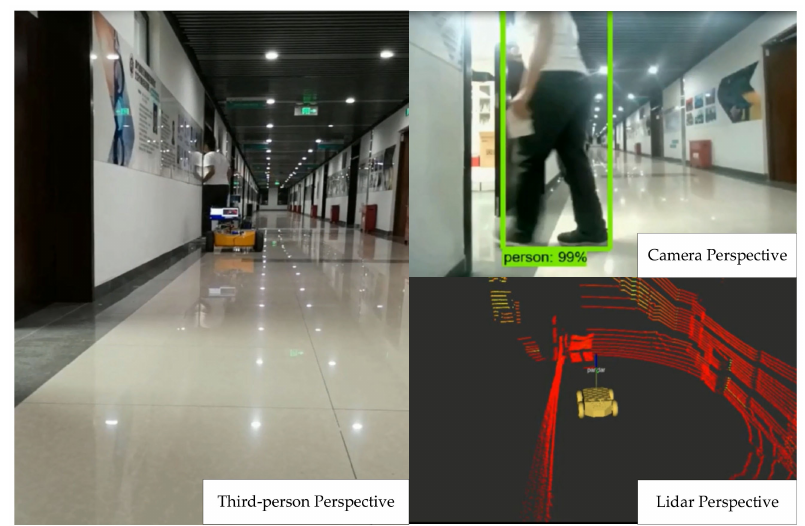
Figure 4. An example of collision